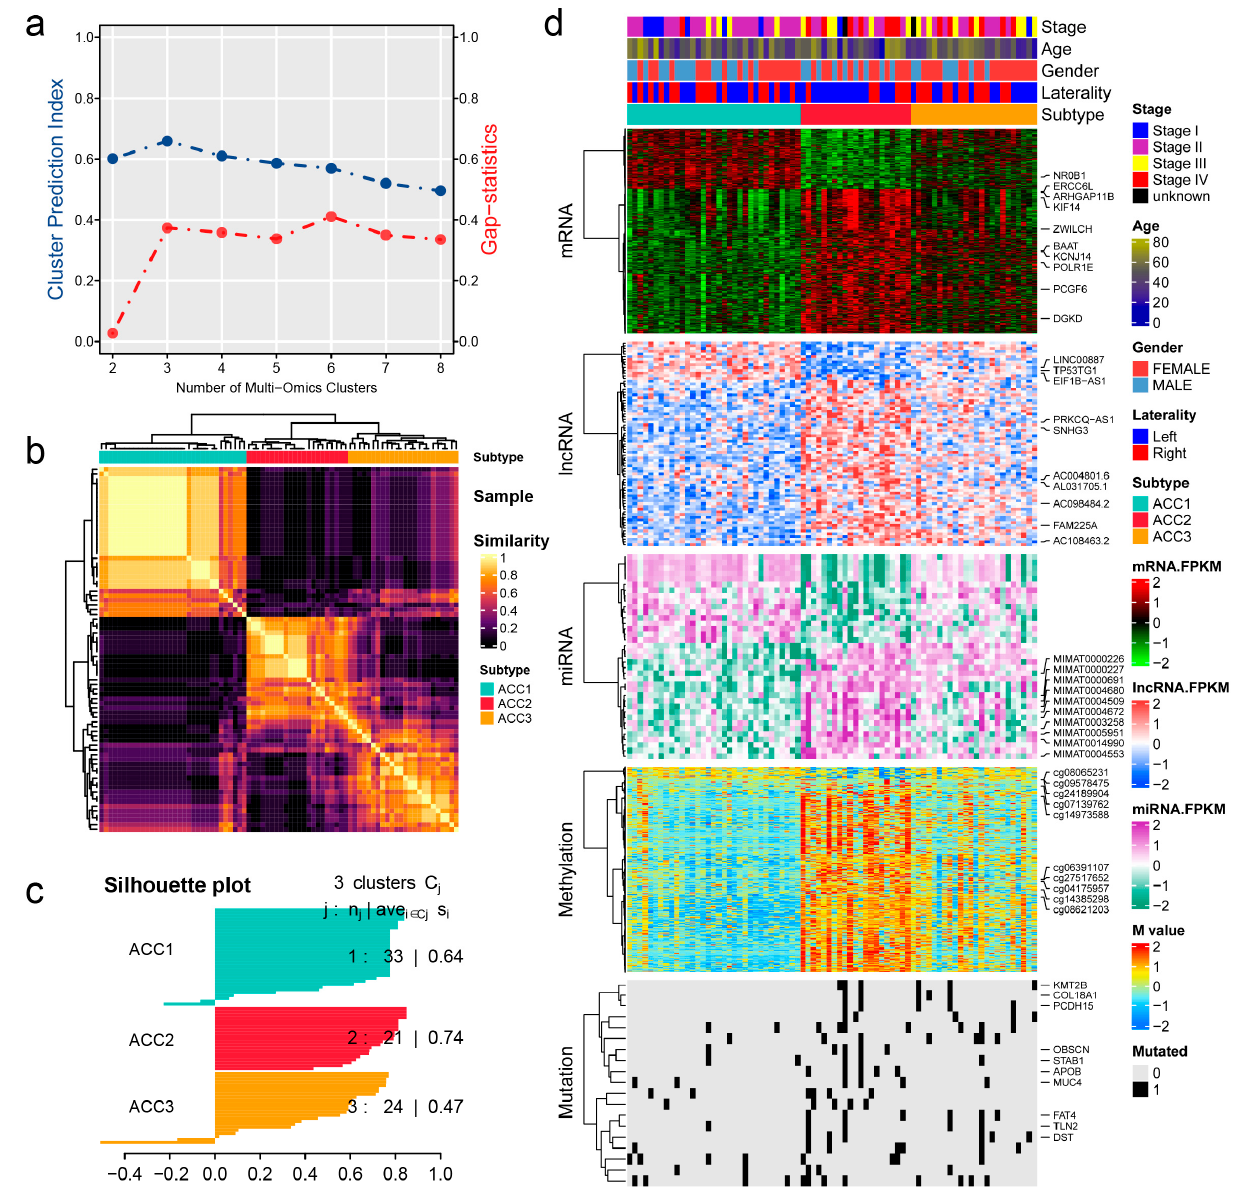
Figure 1. Recognition of the adrenocortical carcinoma multi ‐ omics classification system in the TCGA ‐ ACC cohort. ( a ) CPI analysis and gap ‐ statistical analysis results. ( b ) Consensus matrix for three clusters based on the 10 algorithms. ( c ) Silhouette ‐ analysis evaluation of cluster quality. ( d ) Visualization of multi ‐ omics data for mRNAs, lncRNAs, miRNAs, DNA CpG methylation sites, and mutant genes.